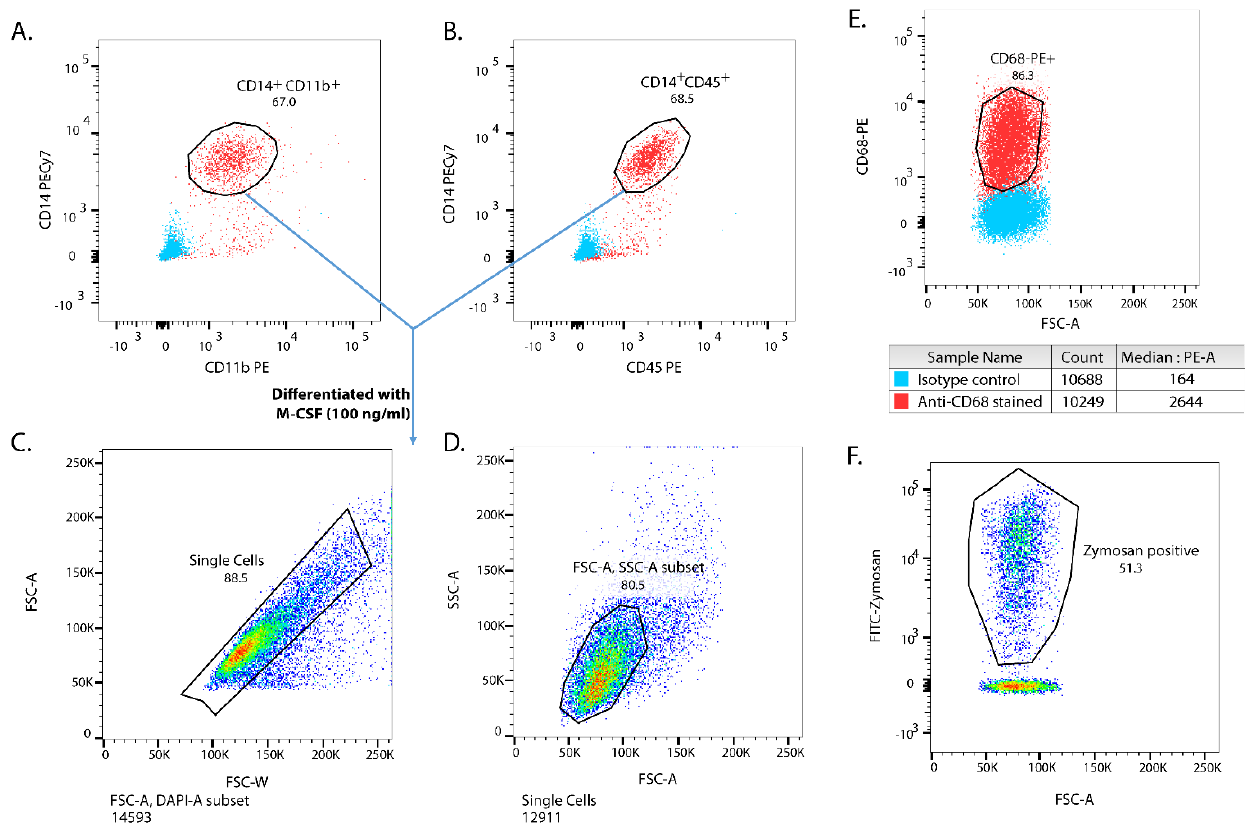
Figure 1. Induced pluripotent stem cell (iPSC)-derived monocytes and macrophages (M Φ ). iPSC- derived monocytes were tested for the expression of monocyte markers, such as CD14, CD11b ( A ), and CD45 ( B ). iPSC derived monocytes were differentiated into macrophages in X-VIVO15 medium supplemented with M-CSF (100 ng/mL) for 7 days. Gating strategy for iPSC derived-M Φ (iPSDM) is shown ( C , D ). iPSDM were stained for the macrophage marker CD68 ( E ) and tested for their phagocytic activity using fluorescein conjugated Zymosan particles ( F ).